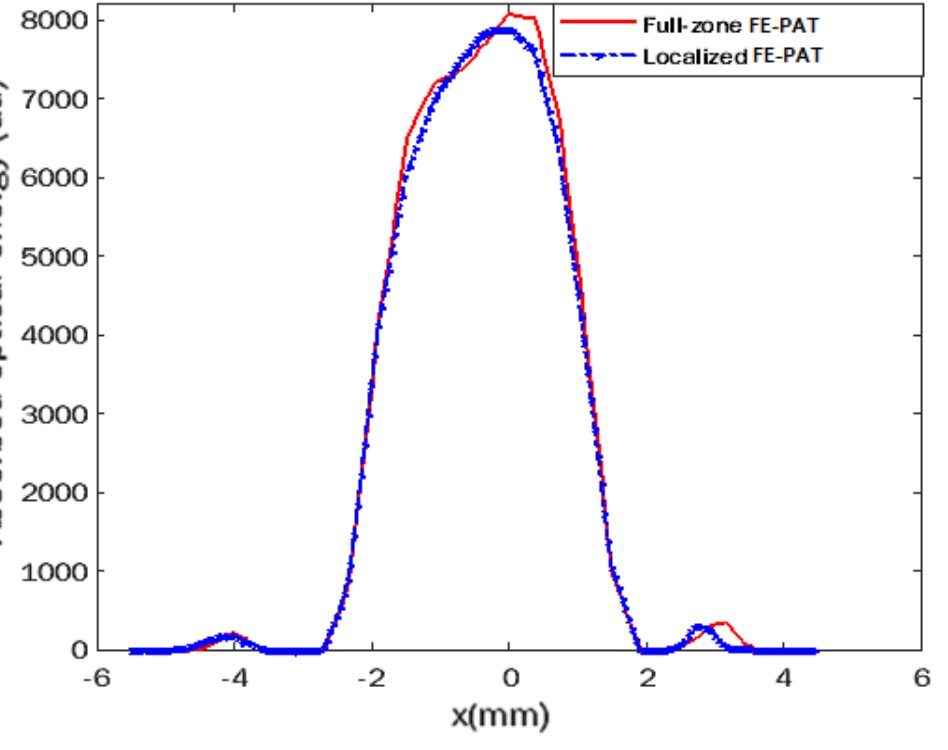
Figure 5. The comparison of reconstructed photoacoustic intensities (absorbed optical energies) across the center of the target in the phantom using the full zone-based FE-PAT algorithm and the localized FE-PAT algorithm in a ROI with a radius of 4.0 mm.